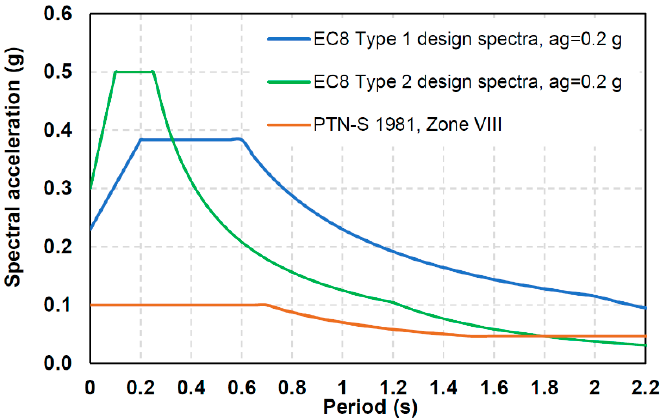
Figure 2. Design response spectra for Kraljevo, Serbia according to PTN-S (seismic intensity VIII, soil Category II) and Eurocode 8 ( a g = 0.2 g, ground type C, q = 1.5).